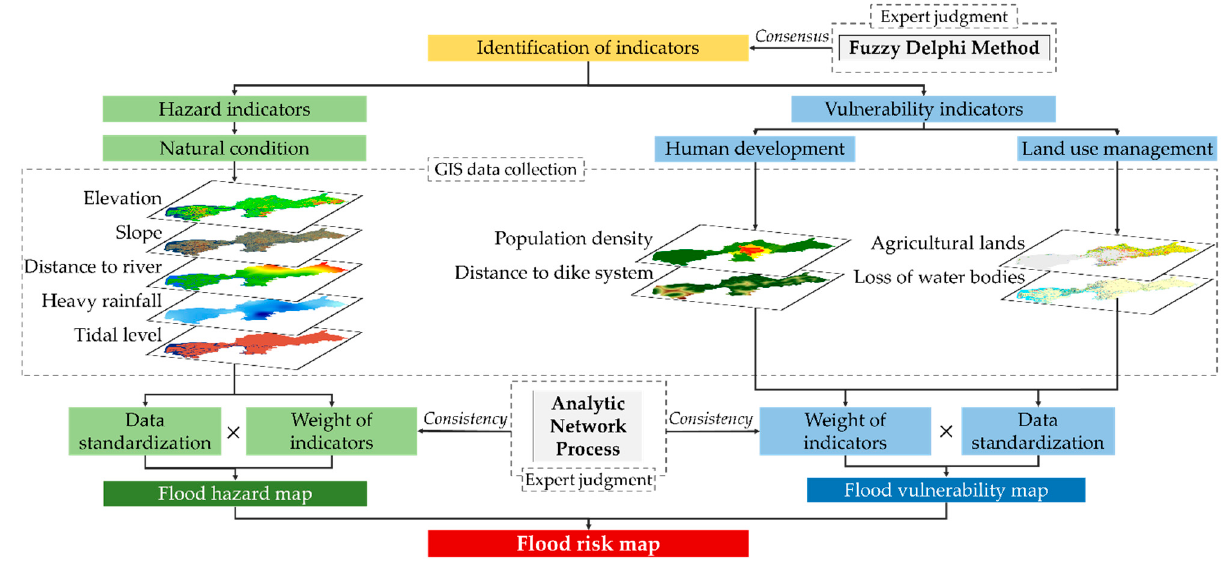
Figure 2. The coupled nature–human flood risk assessment framework.